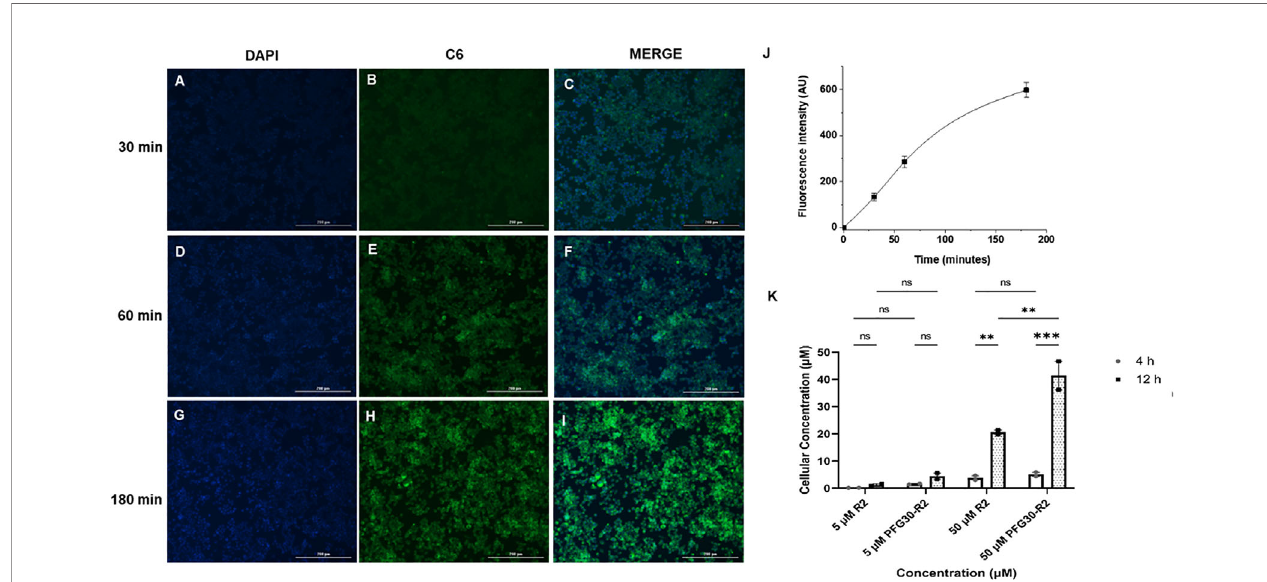
FIGURE 6 | PFG30 encapsulation of Retro-2 (R2) increases uptake of the drug into RAW264.7 macrophages. (A – I) Representative microscope images (magni fi cation 10X) of PFG30 + C6 nanoparticle uptake by RAW264.7 macrophages at different incubation time. RAW264.7 macrophages were incubated at 37°C with PFG30 encapsulated C6 at the following time points: (A – C) 30 min, (D – F) 60 min, and (G – I) 180 min. (J) Cell-associated fl uorescence quanti fi cation calculated as a function of time. The curve was generated by performing image analysis (ImageJ software). Results are expressed as the mean of three biological replicates ± standard deviation (n = 3). (K) LC/MS quanti fi cation of R2 concentration in L. amazonensis- infected RAW264.7 macrophages. Cells were treated with R2 or PFG30 encapsulated R2 (PFG30-R2) for 4 or 12 h. At the indicated times, cells were recovered and supernatant was collected. The cell pellets were lysated in RIPA buffer and then sonicated for 15 s twice prior to storage at – 80°C. Statistical signi fi cance was determined by two-way ANOVA in GraphPad Prism 8 with the Tukey posthoc test for multiple comparisons (ns, not statistically signi fi cant where p-value > 0.05, **p-value < 0.01, ***p-value < 0.001). Data were compiled from two biological